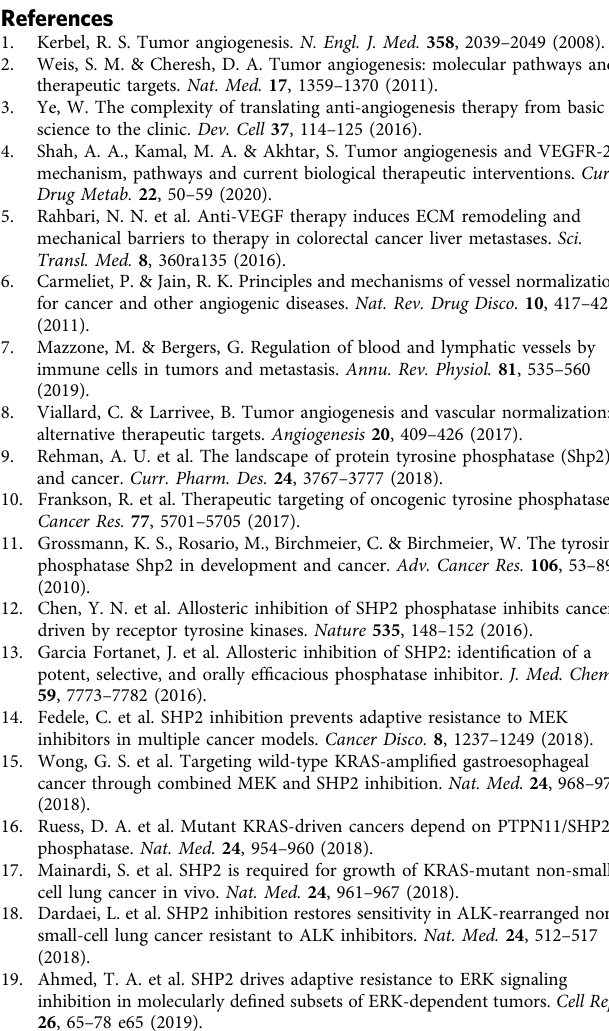
Figure 1d, Supplementary Fig. 7f, g were generated from the NCBI ’ s Gene Expression Omnibus (GEO) database GSE118904 42 . The transcription factor prediction data were generated by Qiagen Transcript Discovery plugin and from PROMO (http:// alggen.lsi.upc.es/cgi-bin/promo_v3/promo/promoinit.cgi?dirDB = TF_8.3) and JASPER (http://jaspar.genereg.net/). The remaining data supporting the fi ndings of this study are available within the article, Supplementary Information, or source data fi le. Source data are provided with this